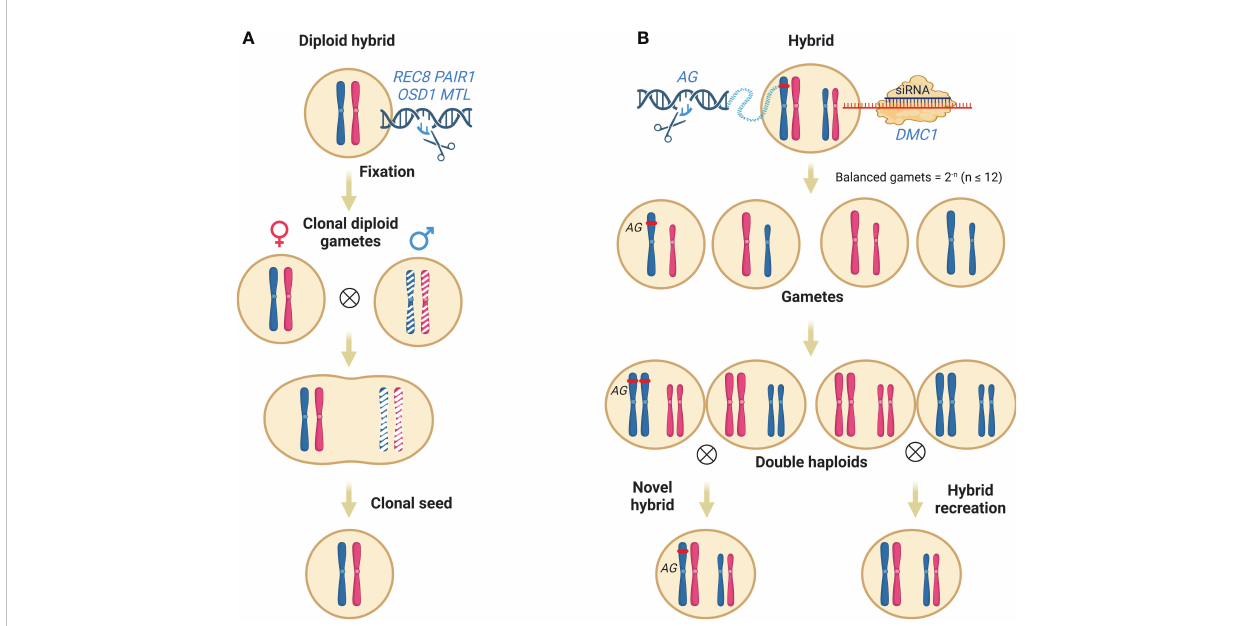
FIGURE 3 Maintain heterozygosity through clonal seed and/or reverse breeding. (A) Maintain heterosis of a tetra mutant. Firstly, the knockout of REC8 , PAIR1 and OSD1 leads to the production of 2n pollen without meiotic recombination. Secondly, by introducing the mutation of haploid induction associated gene MTL , the extra paternal genome is eliminated upon fertilization, resulting in the production of clonal seeds. (B) recreation of hybrid by reverse breeding. Reverse breeding starts from a fully heterozygous hybrid by knock-down DMC1 to suppress meiotic recombination, leading to the generation of balanced gametes without meiotic recombination at a certain percentage (2 -n , n is the number of a set of chromosomes). A population of doubled haploids is then converted from the non-recombined haploids, which can be used to recreate hybrids. In addition, novel parental lines can also be created by genome editing of key genes that regulate desirable traits, such as the double- fl ower phenotype ( AG for example). Abbreviations include REC8, meiotic recombination protein; PAIR1, homologous pairing aberration in rice meiosis1; OSD1, omission of second division; MTL, MATRILINEAL; AG, AGAMOUS; DMC1, disrupted meiotic cDNA1. This fi gure was created with